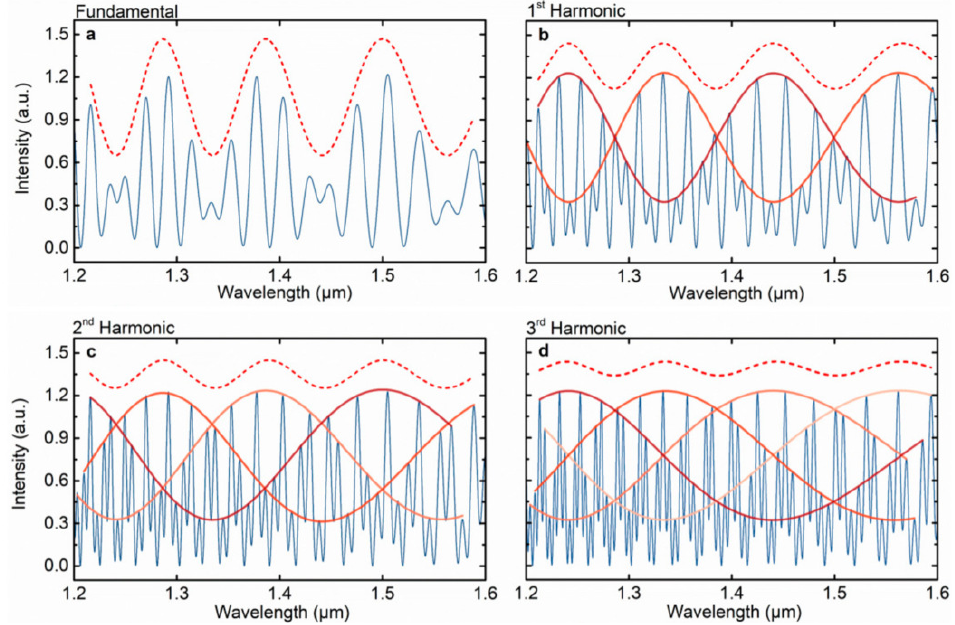
Figure 16. Numerical simulations of the fundamental Vernier effect ( a ), and the first three harmonic orders ( b – d ) [8]. Blue line: Simulations of the Vernier effect spectra. Dashed line: Upper envelope (shifted upward to be distinguishable from the internal ones). Red-orange lines: Internal